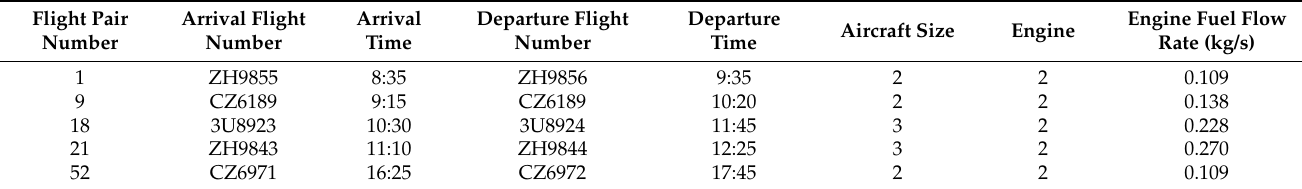
Table 2. Example of arrival and departure flight data at the ZSNJ